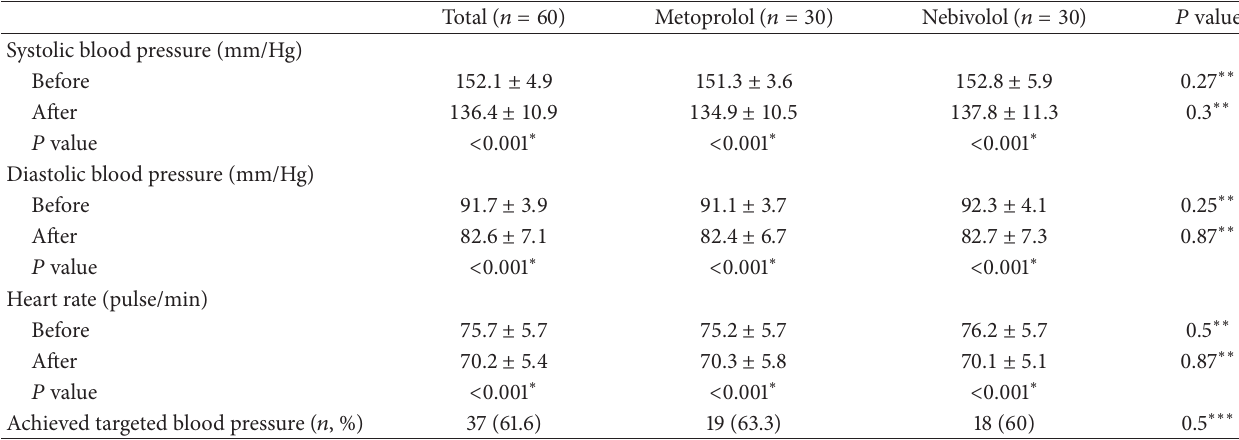
Table 2: The values of blood pressures and heart rates prior to and after the treatment with metoprolol and nebivolol in the study